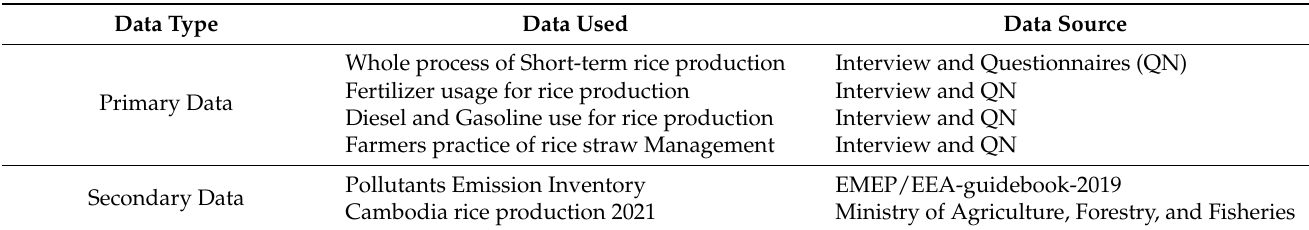
Table 2. Sources of input data for analysis.